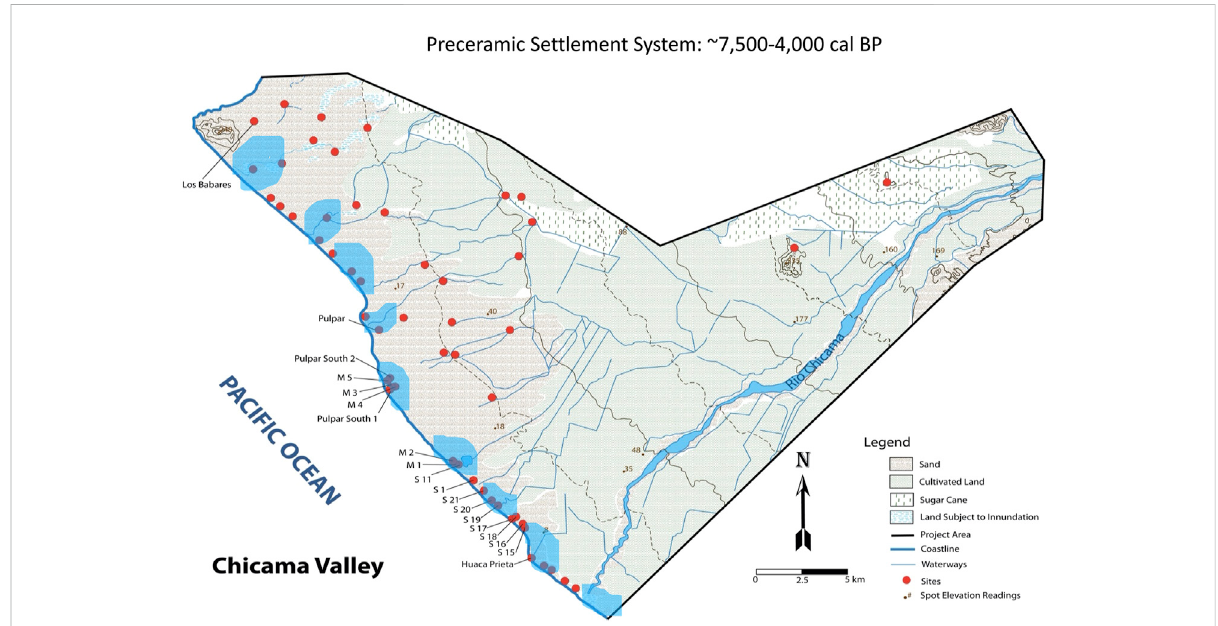
Location map of domestic sites (red dots), lagoons and wetlands (blue), narrow washes, geological coring and pro fi ling sites (red dots and wetlands), Huaca Prieta and the Chicama River. Red dots represent clusters of domestic